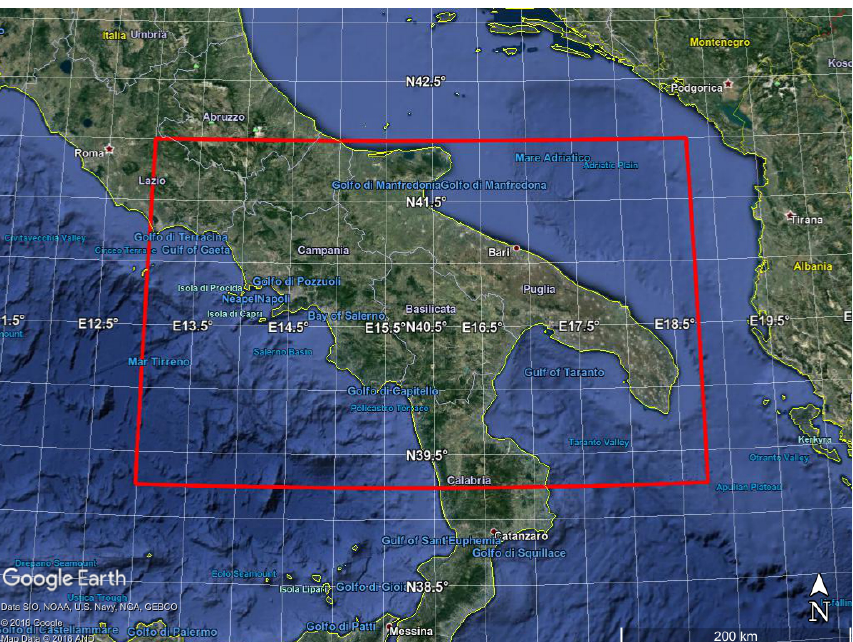
Figure 1. SEVIRI target area over South Italy (red rectangle) used to check the retrieval algorithms.